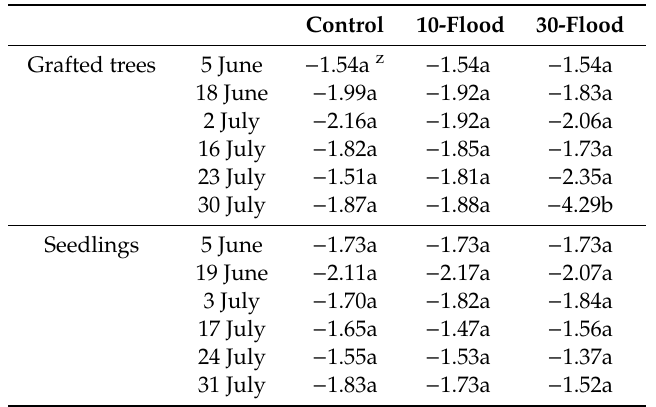
Table 1. E ff ects of flooding treatments at di ff erent water depths in leaf water potential (Mpa) of grafted Table 1. Effects of flooding treatments at different water depths in leaf water potential (Mpa) of mango trees and seedlings. grafted mango trees and seedlings.